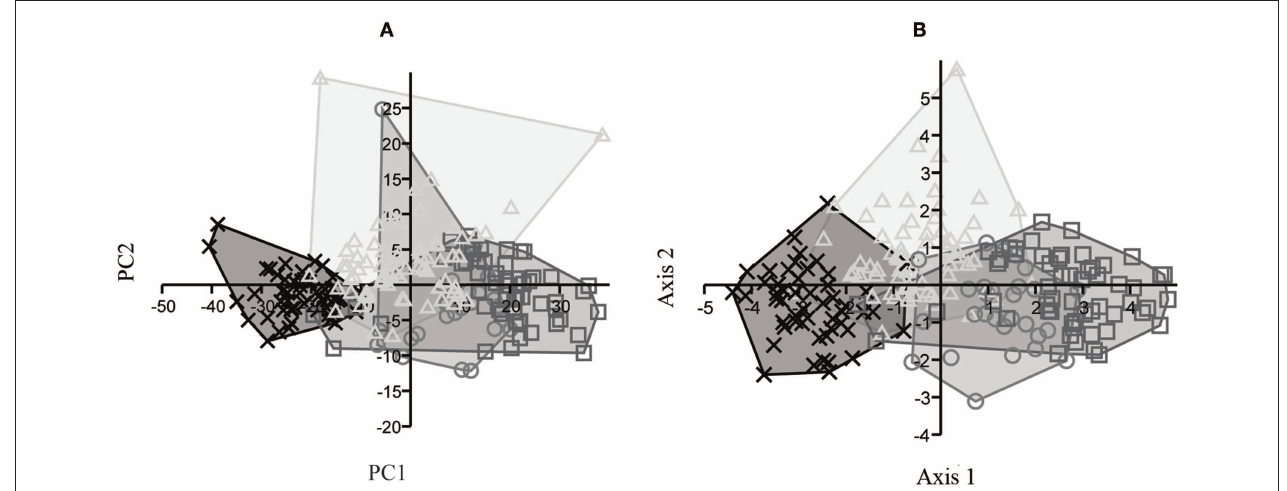
FIGURE 9 | IPHIII analysis for E. andium (x), E. insulatus (triangle), E. neogeus (circle), and E. occidentalis (box): (A) projected scores from PCA, PC1 (82%) and PC2 (7%); (B) dispersal graph from CVA, axis 1 (90%) and axis 2 (5%).